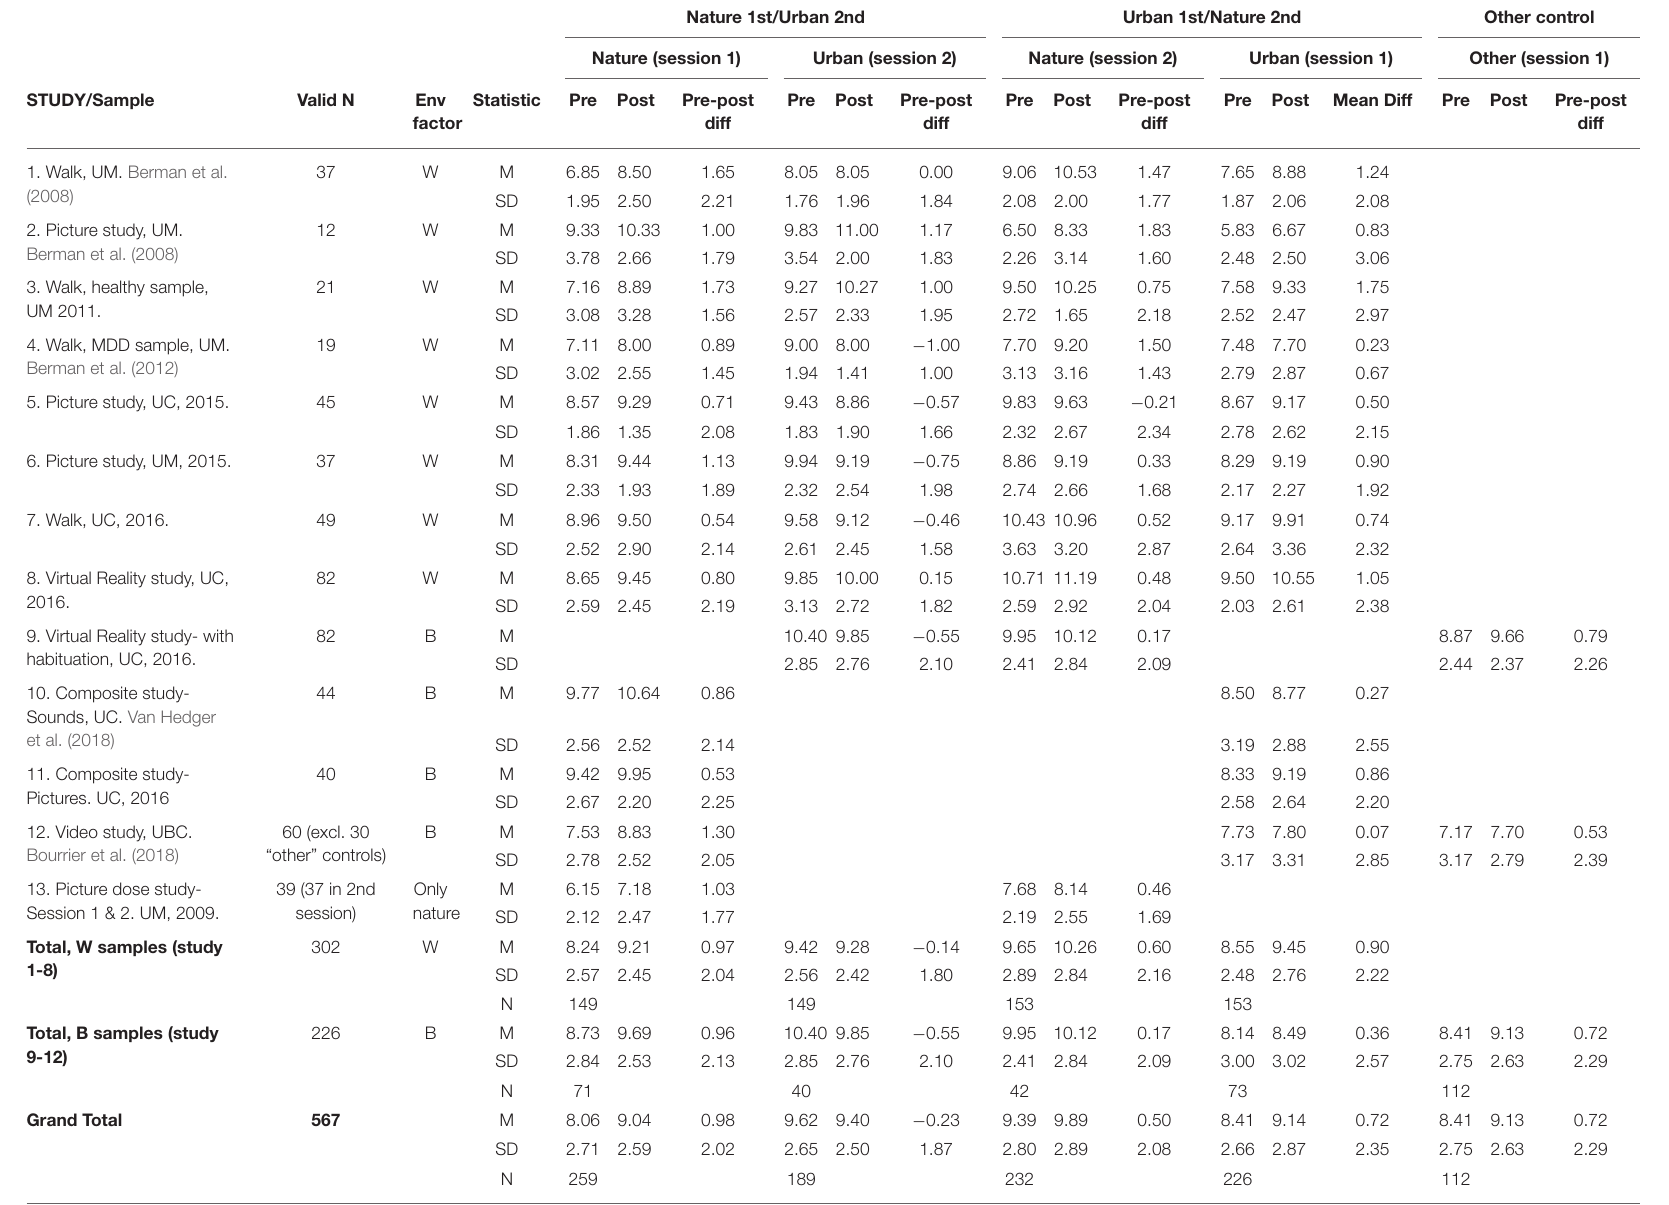
TABLE 2 | Mean BDS scores by study, time (pre- vs. post environment exposure), environment condition, and order (test session). Nature 1st/Urban 2nd Other